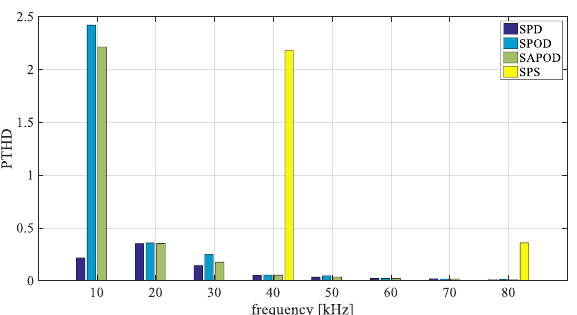
Figure 16. Comparison of PTHD values for modulation index equal to 0.9.